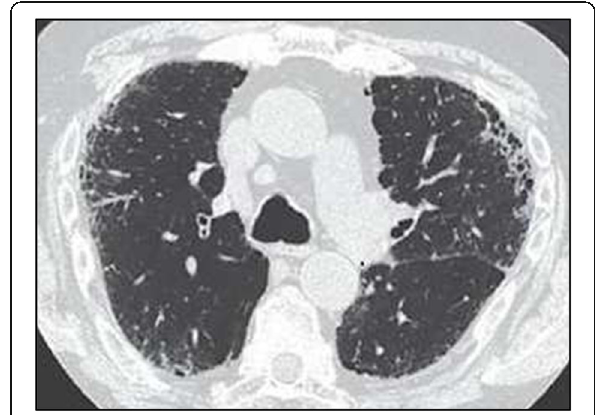
Fig. 5 A 56-year-old male smoker patient, working as a concrete board cutter for 32years, was diagnosed as having asbestosis for 6 years with a latent period of 26years. Axial CT scan lung window showing bilateral subpleural reticulation and coarsening of pulmonary interstitium associated with honeycombing denoting interstitial fibrosis